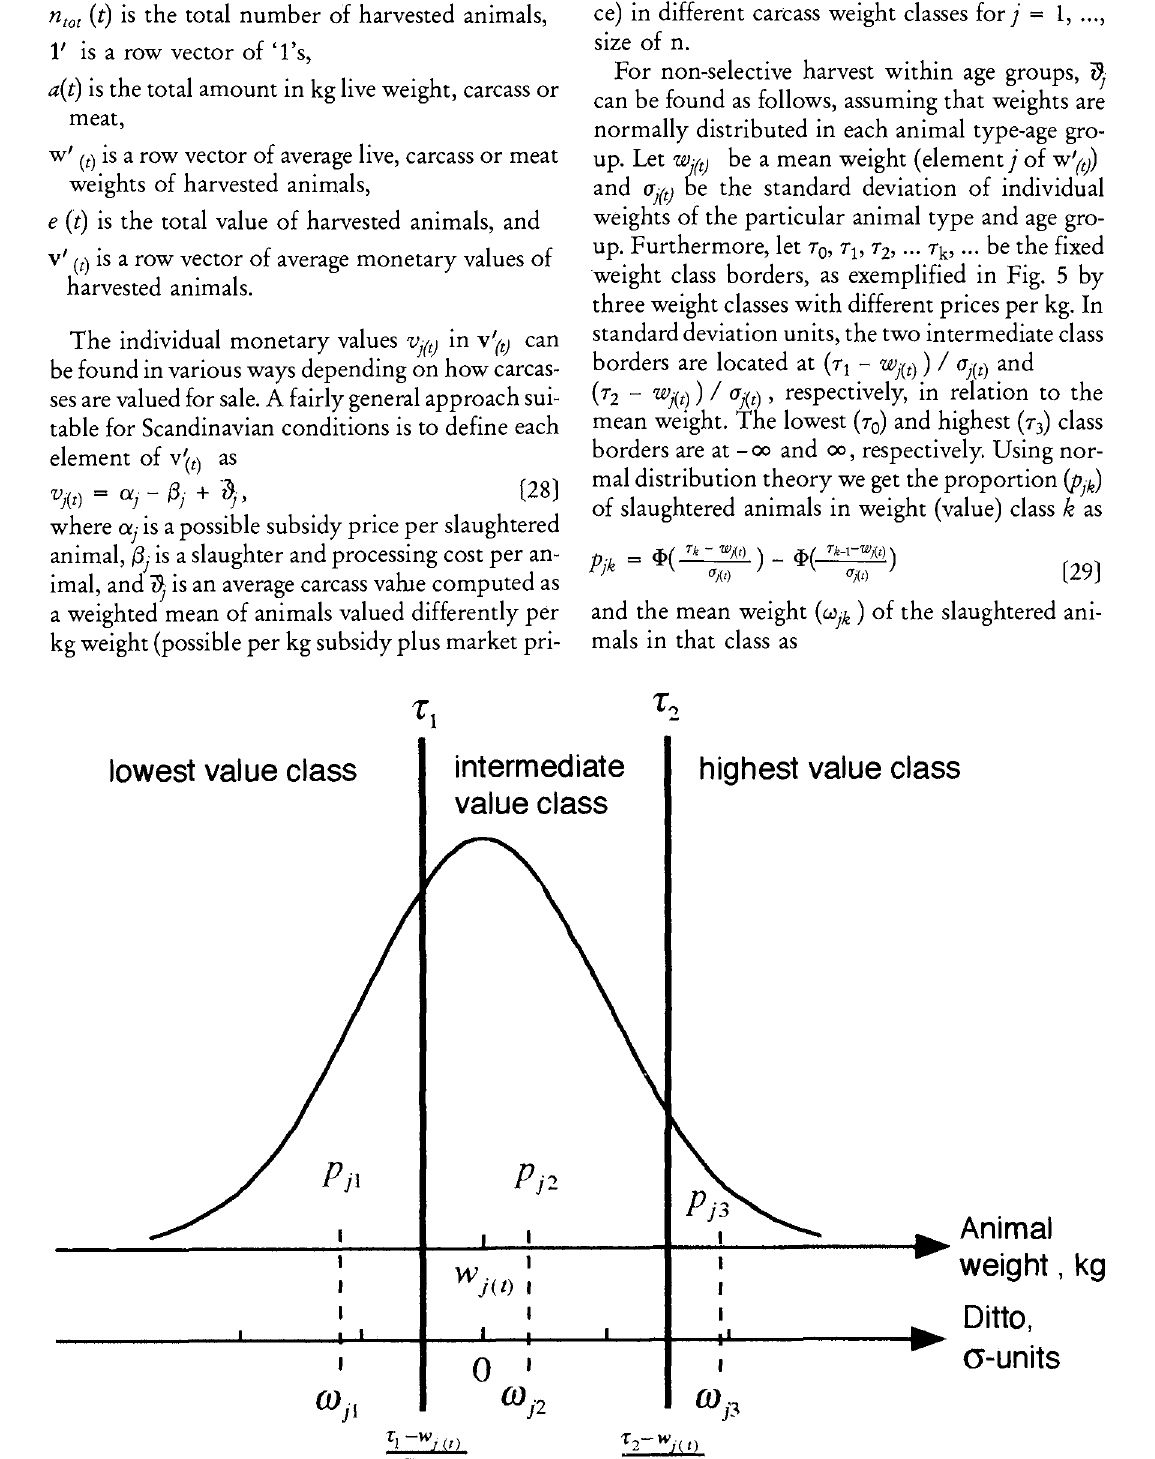
Fig. 5. The distribution of individual weights of animals in compartment j at time t divided in three weight classes representing different carcass or meat values per kg weight. Symbols are explained in the text.